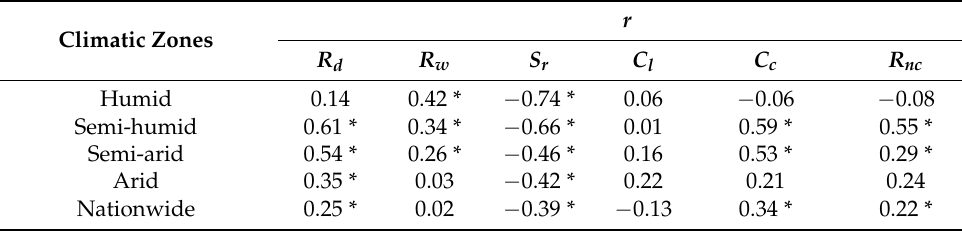
Table 4. Pearson correlation coefficient ( r ) between WER and SCCs in different climatic zones.